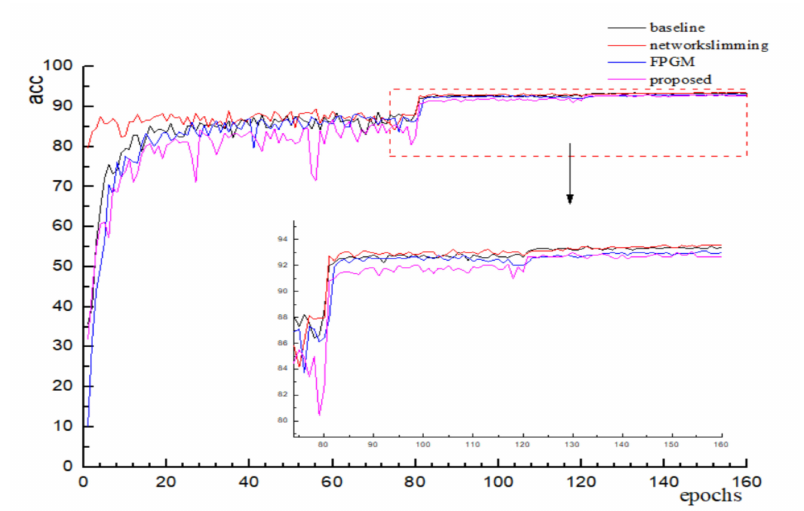
Figure 5. Variation of accuracy in VGG16. ResNet-56. On CIFAR10, with similar parameters and FLOPs, our algorithm based on information entropy stratification enables ResNet56 to obtain an accuracy of 93.21% with 0.31 M parameters and 45.78 M FLOPs, respectively. In addition, using our fusion pruning algorithm is effective in reducing the computation with a slight loss of accuracy. This shows that our algorithm is suitable for pruning residual